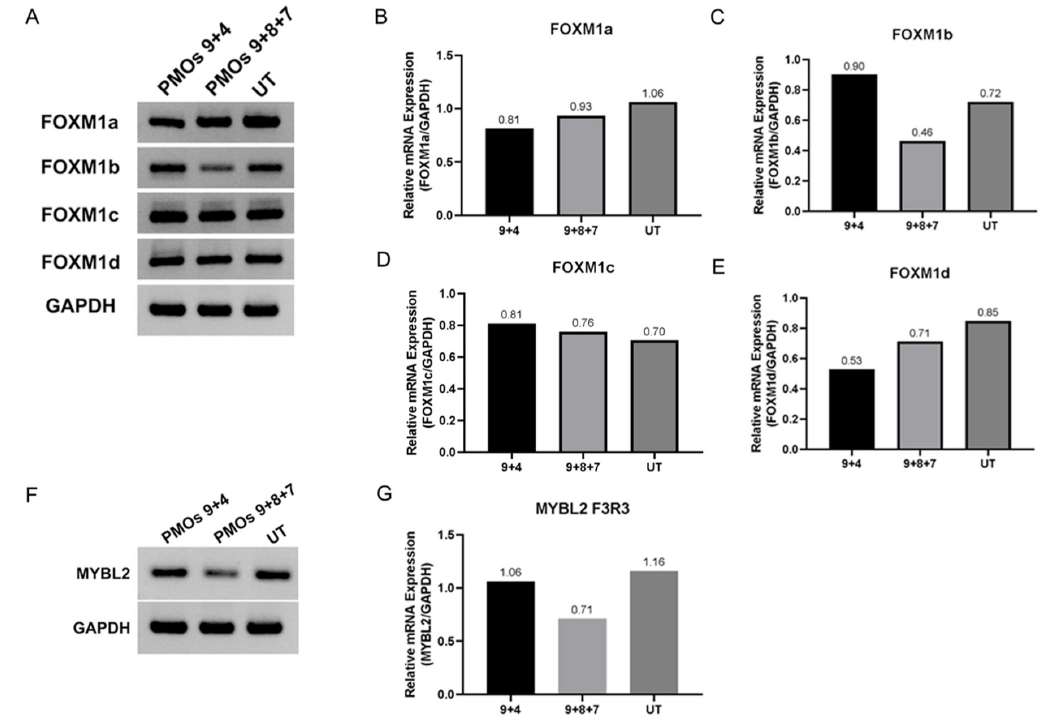
Figure 7. Isoform specific RT ‐ PCR to detect four different isoforms of FOXM1 ( A ) with the graph displaying band densitometry in the panels ( B )–( E ) (viz FOXM1a, FOXM1b, FOXM1c and FOXM1d) showed reduced expression of FOXM1b in cultured SMA fibroblasts treated with the combination of PMOs 9 + 8 + 7, while RT ‐ PCR analysis of MYBL2 ( F ) was also reduced, as indicated in its band densitometry ( G ).